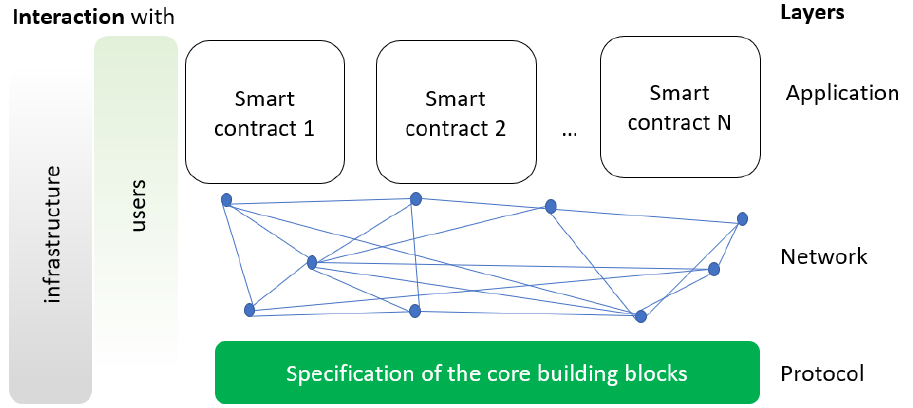
Figure 1. The blockchain based electricity settlement system layers.